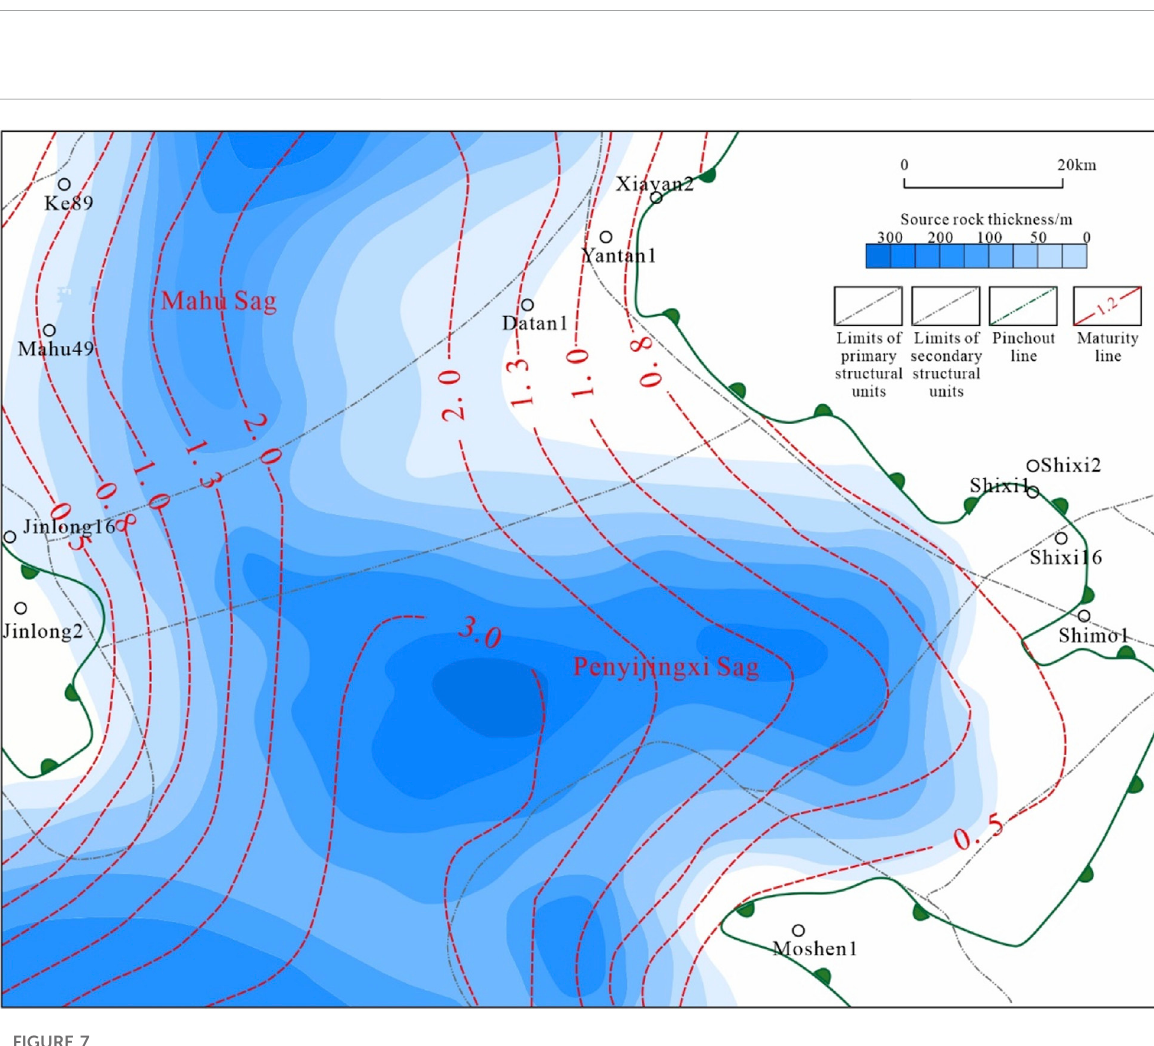
Frontiers in Earth